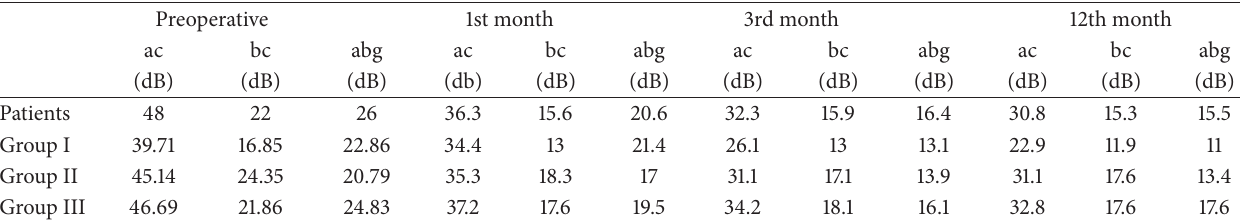
Table 3: Preoperative and postoperativehearing threshold averages and air-bonegaps measured inall thepatients and themastoidventilation